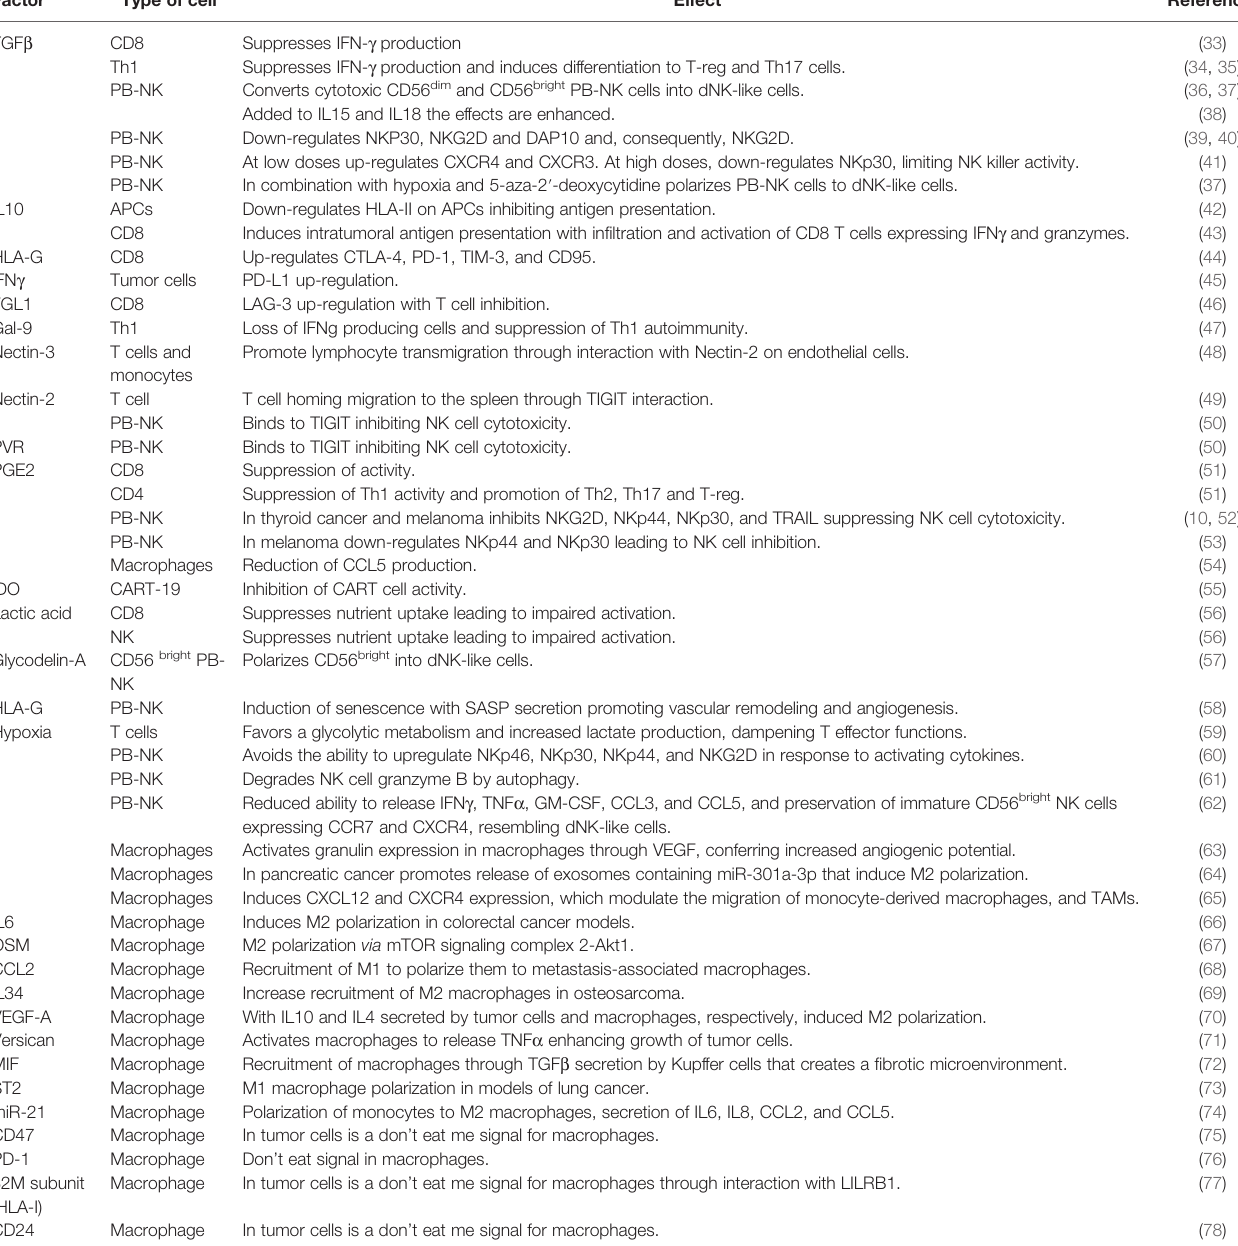
TABLE 2 | Impact of secreted factors in the tumor microenvironment (TME) over the different immune cell populations and description of receptors acting as eat me or don ’ t eat me signals for phagocytic activity of macrophages. Factor Type of